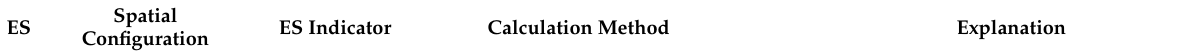
Table 1. Assessment indicators and calculation formulas of five crucial ESs provided by linear water